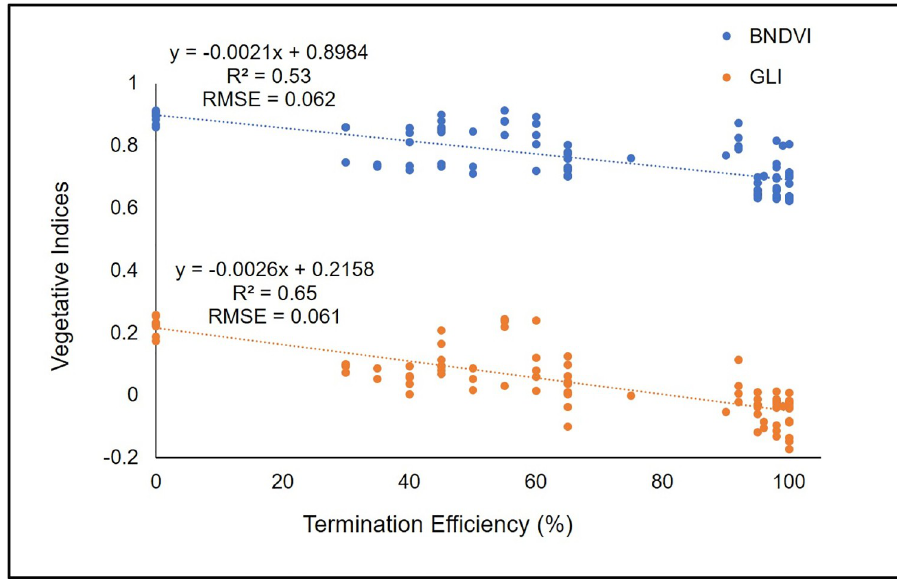
Fig 6. Scatter plot of Blue Normalized Difference Vegetation Index (BNDVI) and Green Leaf Index (GLI) response to termination efficiency (n = 88 for each vegetative indices) in cereal rye. R 2 = Coefficient of determination, RMSE = Root Mean Square